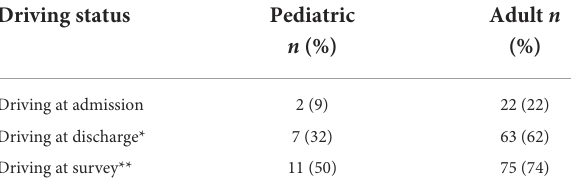
TABLE 3 Driving status.